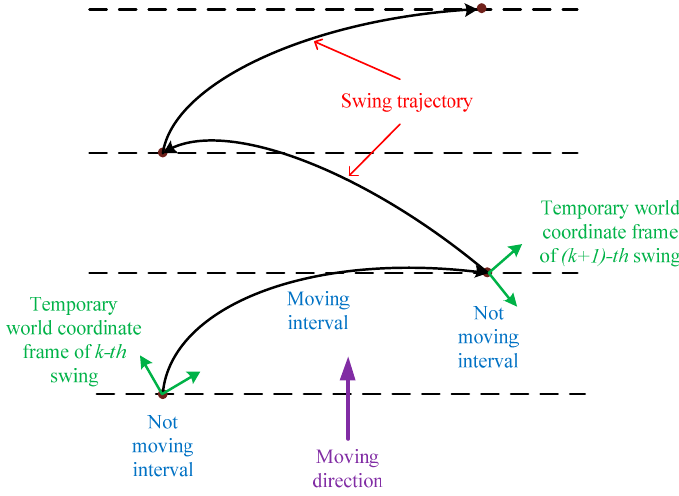
Figure 3. User’s swing motion.